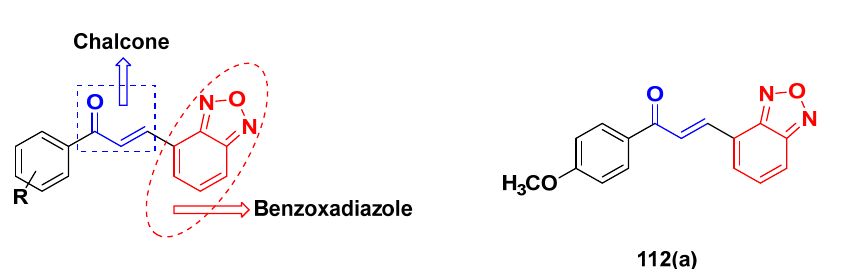
Figure 107. Structure of chalcone-based benzoxadiazole hybrids and the most promising compound 112a.